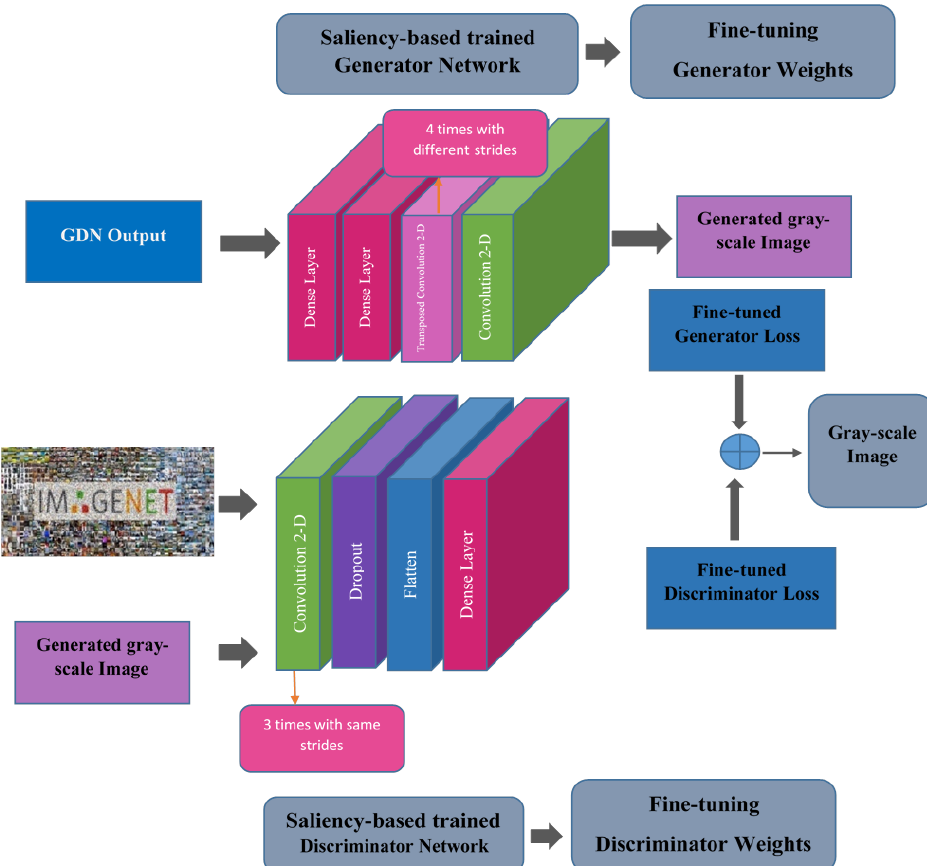
Figure 8. The block diagram of the GAN part of the proposed GDN-GAN for image